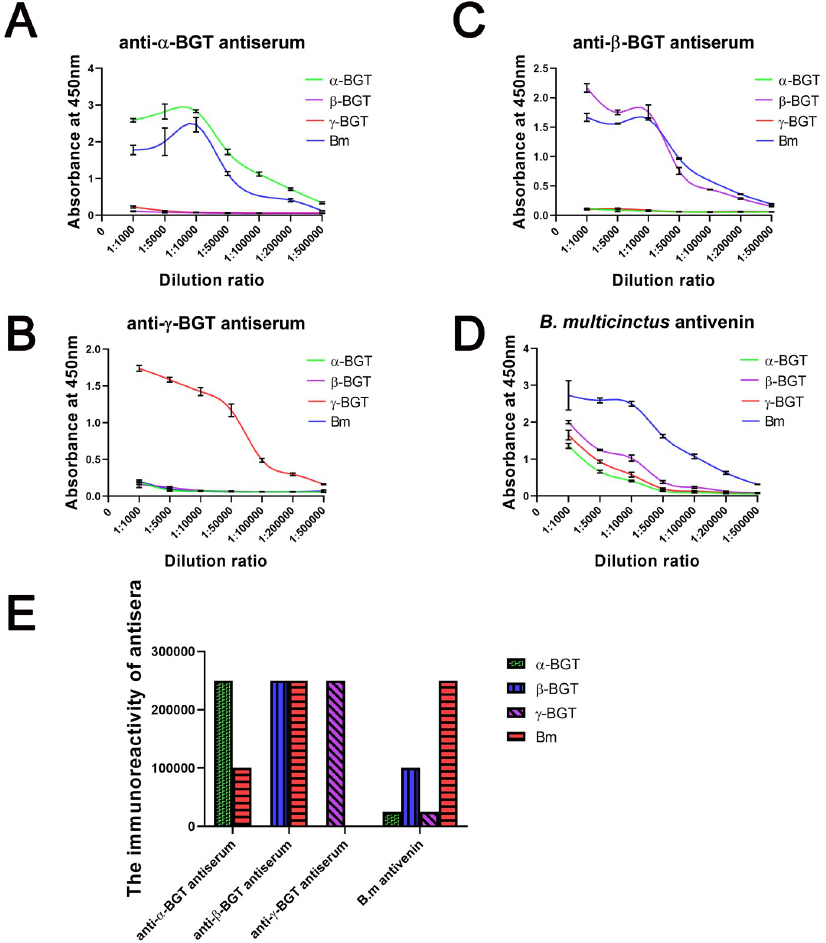
Fig 3. The immunoreactivity of antisera comparison by indirect ELISA. Prepared anti- α -BGT antiserum against different antigens (A). Prepared anti- γ -BGT antiserum against different antigens (B). Prepared anti- β -BGT antiserum against different antigens (C). Commercial B . multicinctus antivenin against different antigens (D). The immunoreactivity determination of prepared antisera and the B . multicinctus antivenin (E). Antigens of 1 μ g/well were coated on a 96-well plate, results were expressed as mean ±